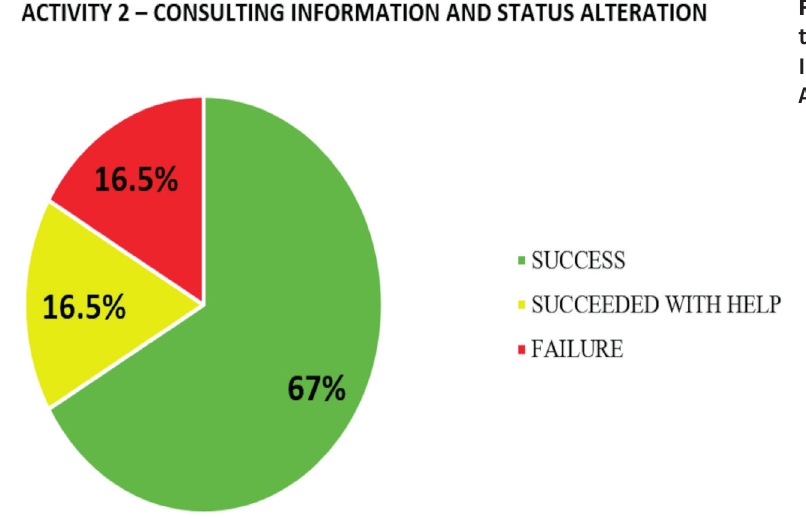
Figure 14. Graph regarding the activity “Consulting Information and Status